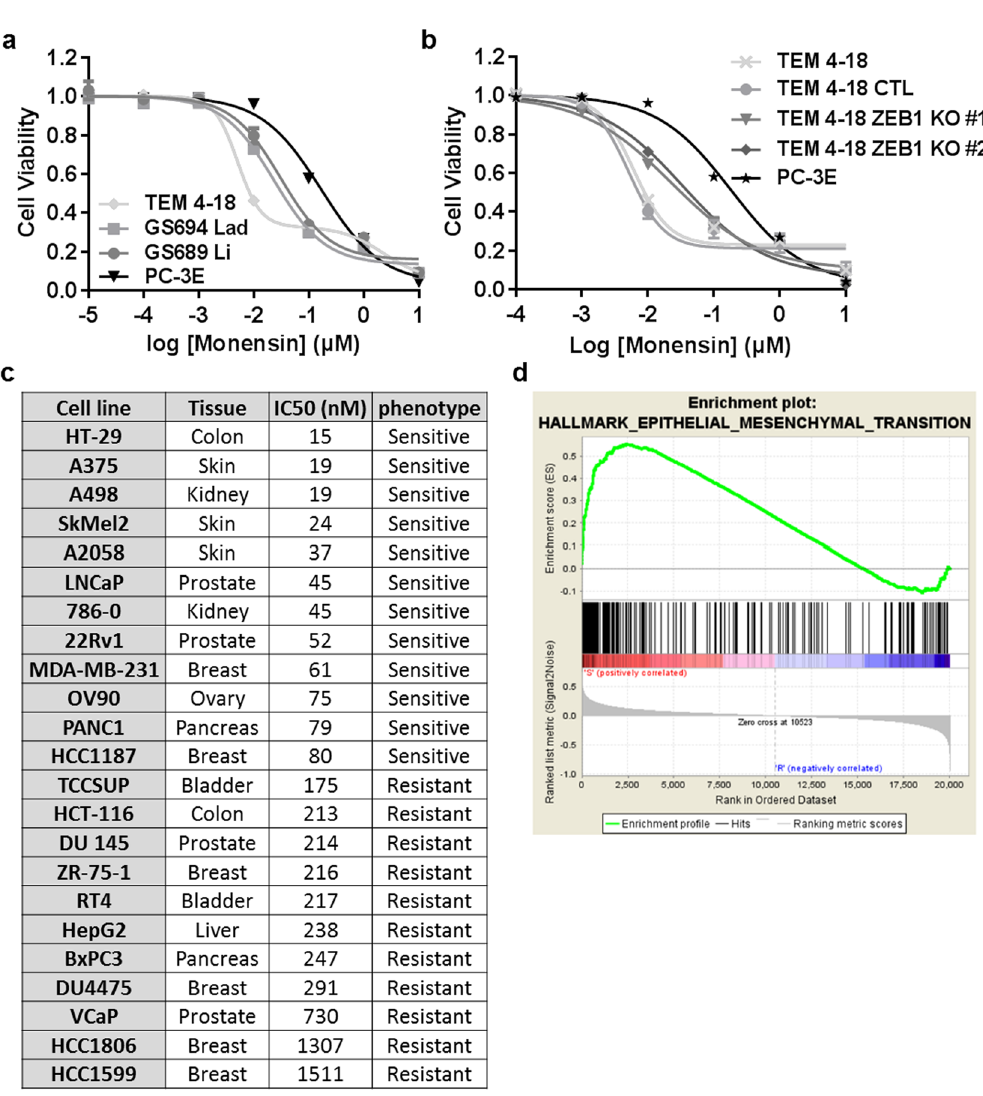
(Fig. 6b). While ZEB1 KO significantly increased the IC 50 to monensin in independent clones by (#1: 4.6 fold; #2: 6 fold) when compared to their respective control, TEM 4-18 ZEB1 KO cells still remained more sensitive to mon- ensin compared to the epithelial PC-3E cells. As all the aforementioned cell lines were derived from the parental PC-3 cell line, we extended our study to a broader panel of human cancer cell lines. Dose-response experiments were performed to evaluate the toxicity of monensin in 23 cancer cell lines and, based on the calculated absolute IC 50 , the cell lines were grouped into a sensitive (IC 50 < 100 nM) or resistant (IC 50 > 100 nM) group (Fig. 6c). To explore whether monensin toxicity is correlated with cell growth rate (as a function of growth medium used (Supplementary Fig. S3) or otherwise), we evaluated the sensitivity of the cell lines to monensin by measuring the growth rate inhibition 50 (GR 50 ), which accounts for differences in growth rates 18 . We note that across this panel of cell lines, monensin-sensitivity as measured by IC 50 and GR 50 were well correlated (Supplementary Fig. S3). We then analyzed publically-available gene expression data (Cancer Cell Line Encyclopedia) and performed a Gene Set Enrichment Analysis to identify the gene sets differentially represented in the 2 groups. Supporting our hypothesis that monensin is selectively toxic to cells in an EMT-like state, the gene set “Hallmark Epithelial Mesenchymal Transition” was the top gene set enriched in the sensitive group (Fig. 6d). To confirm the results of the gene set enrichment analysis, we evaluated the expression of the epithelial marker E-cadherin and the